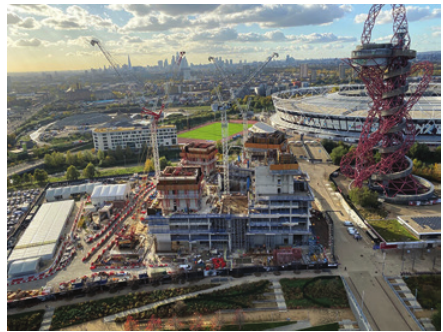
Figure 4 View of the Marshgate building at UCL East, with the Arcelor Mittal Orbit tower, the London Stadium and London in the background, November 2020 (Source: photograph by UCL East,